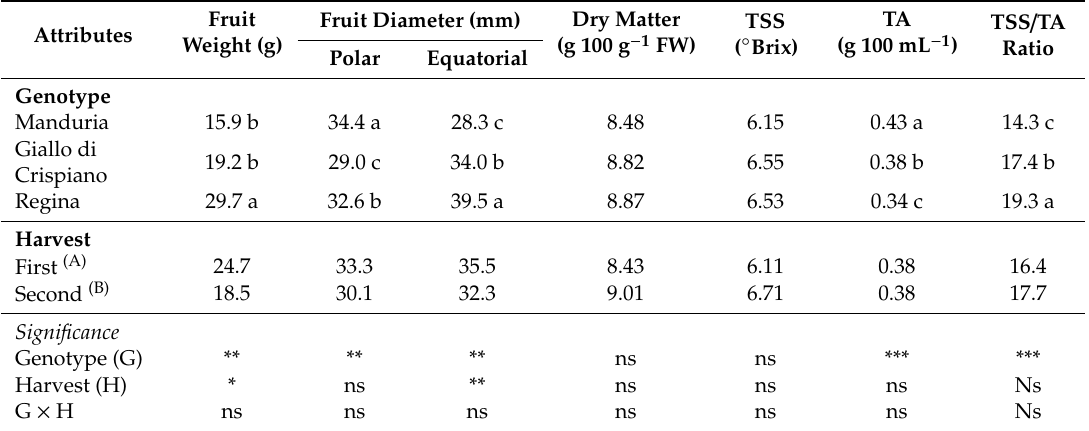
Table 3. Main e ff ects of genotype and harvest time on weight, diameters, dry matter, total soluble solids (TSS), titratable acidity (TA) and TSS / TA ratio of tomato